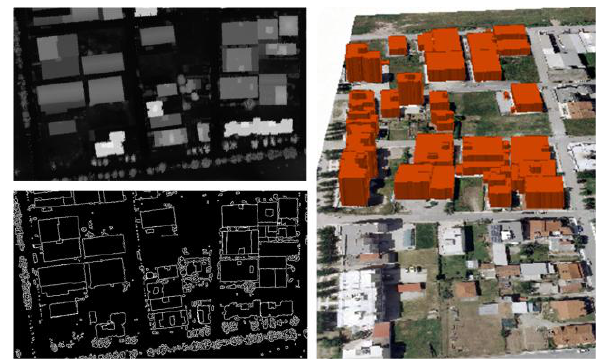
Figure 9. Top left: the DEM of the raw LIDAR point cloud data with a cell size of 40 cm; Bottom left: the corresponding edge map; Right: the extracted 3D models of buildings in terms of LoD 1 superimposed on an orthoimage.